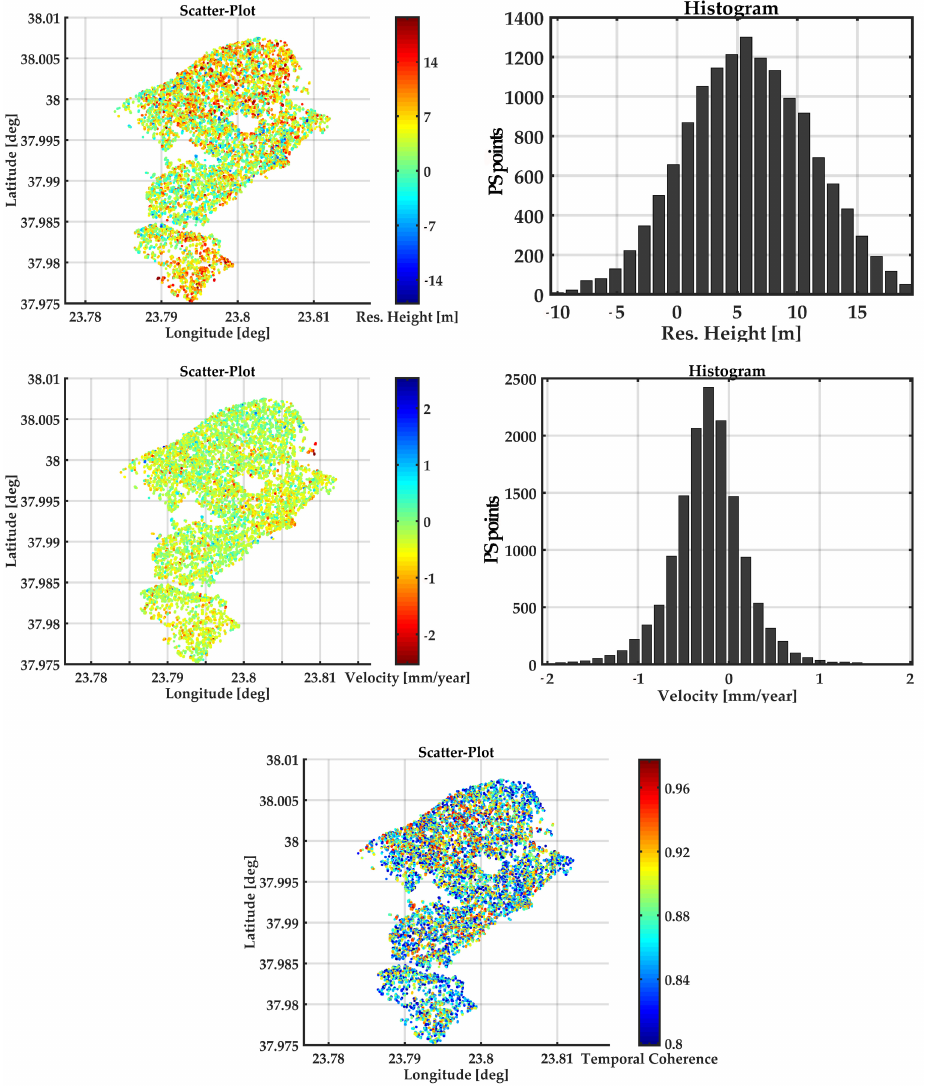
Figure 13. The top is the residual height map with the histogram, on the middle is the deformation velocity map with the histogram and the bottom is the temporal coherence map.